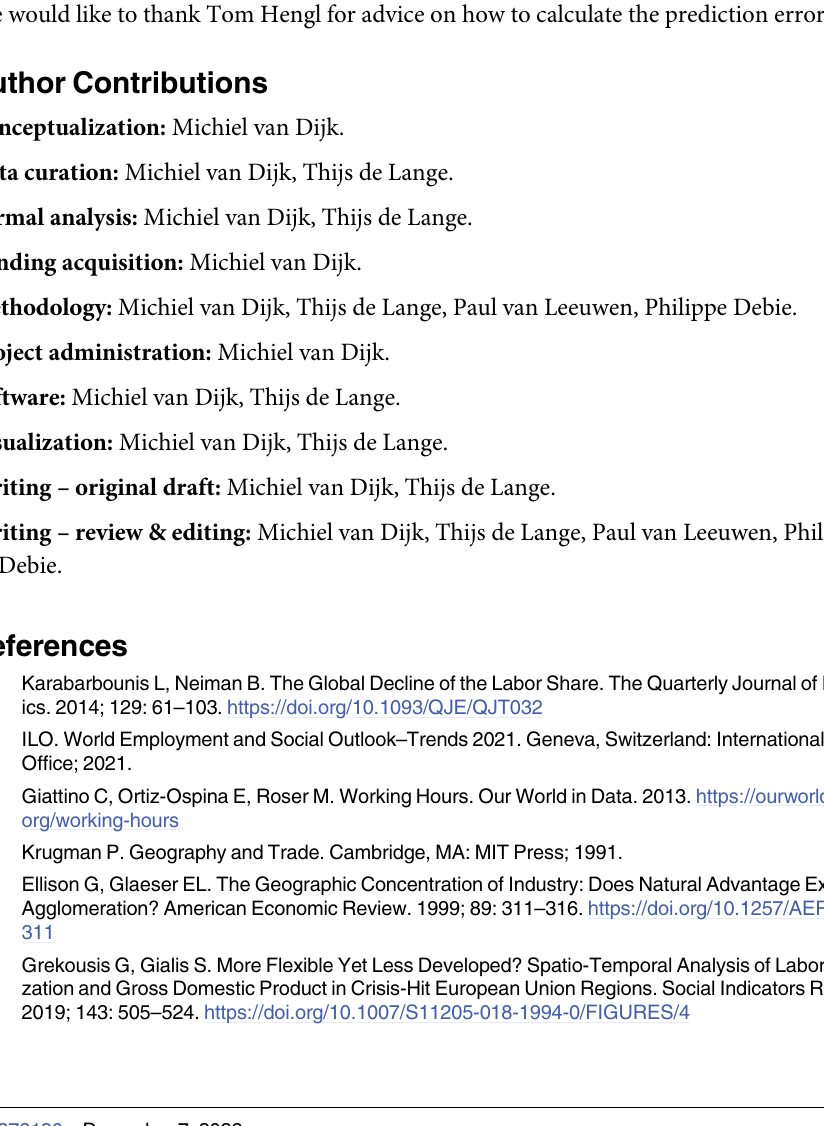
S2 Table. List of selected predictors for the machine learning models.